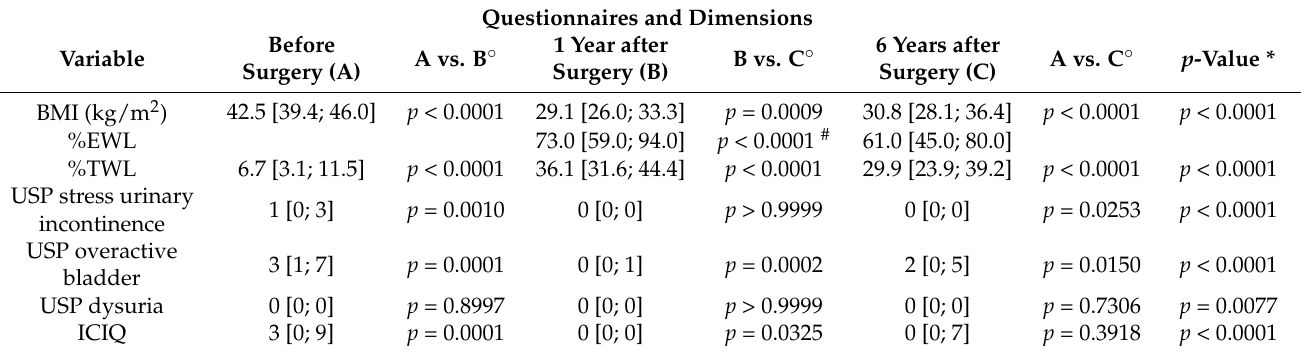
Table 2. Evolution of weight and score results for each questionnaire and dimension (median (IQR)). Questionnaires and